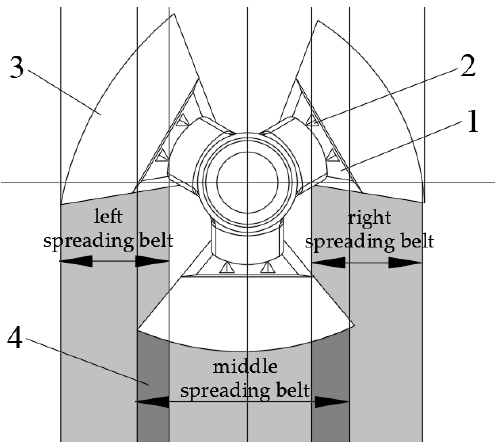
Figure 2. Schematic diagram of the fertilizer strip: 1. fattening small plates, 2. fattening bulges, 3. single plate spreading area, 4. fertilizer spreading overlap zone. 3. single plate spreading area, 4. fertilizer spreading overlap